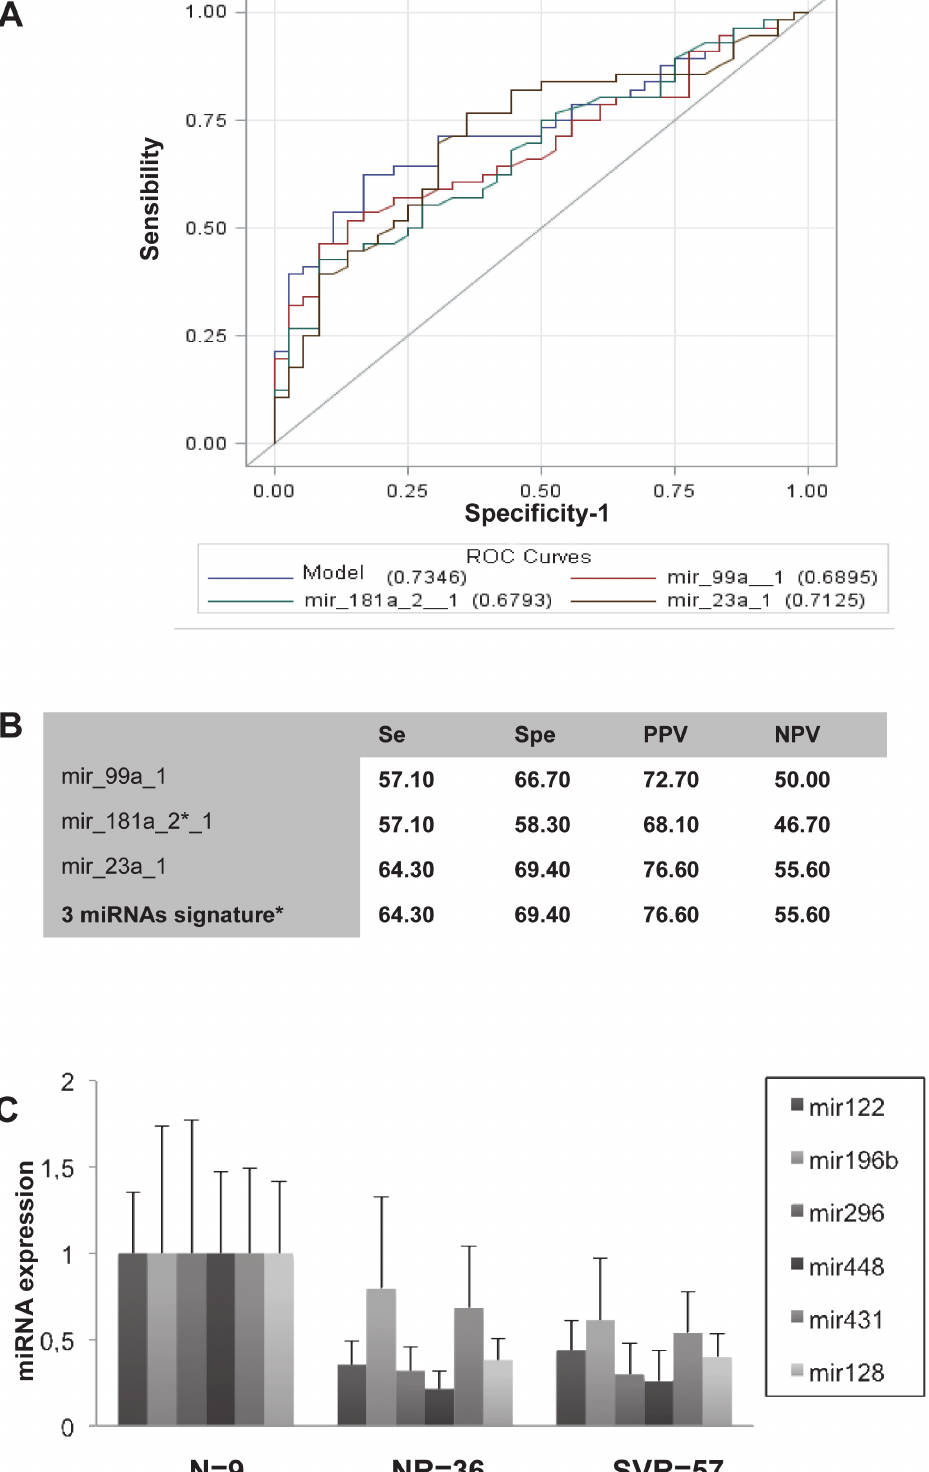
Fig 2. Identification of a 3 miRNAs signature (mir-99a, mir-23a and mir-181a * ) predictor of SVR and selective analysis of miRNAs expression in NRs and SVRs. 2A- The receiver Operator Curves (ROC) were calculated for each miRNAs and for the signature based on the combination of the 3 miRNAs. 2B- The